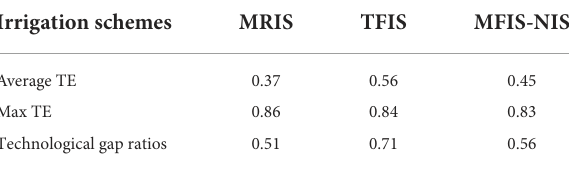
TABLE 3 Technology gap ratios and average technical efficiency scores in KZN